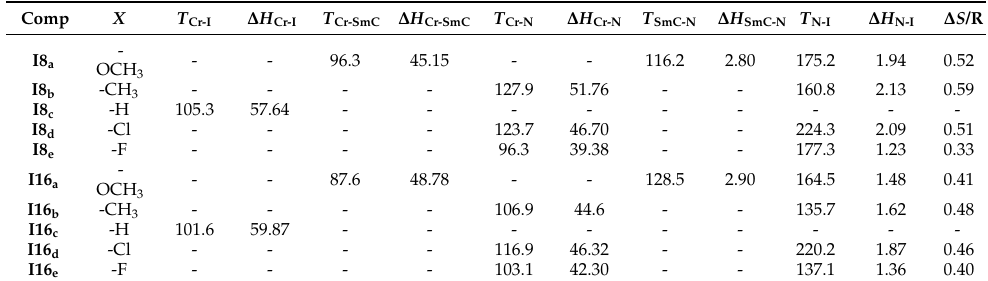
Table 1. Mesomorphic temperature of transitions ( T ◦ C), enthalpy of transition ∆ H , kJ/mole, and normalized entropy of transition ∆ S /R for investigated set, In x